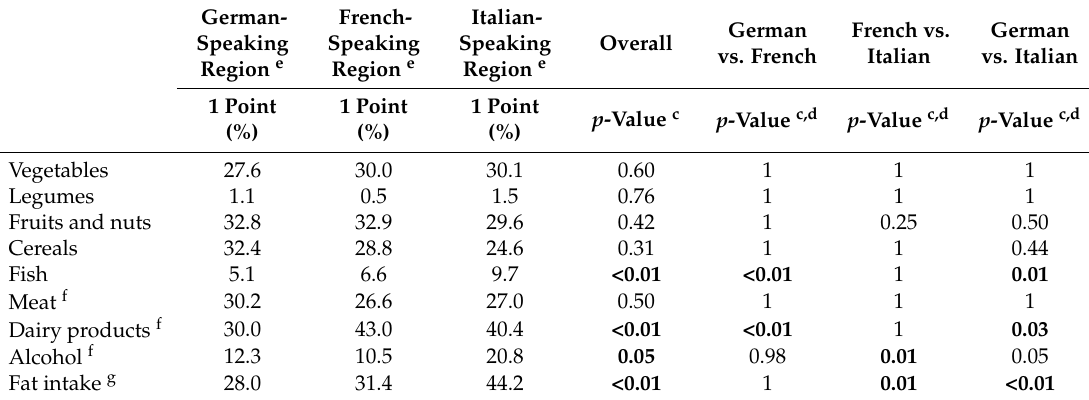
Table 4. Weighted proportions of participants with 1 point in each Mediterranean Diet Score (MDS) component and differences between language regions ( n = 2057) a,b